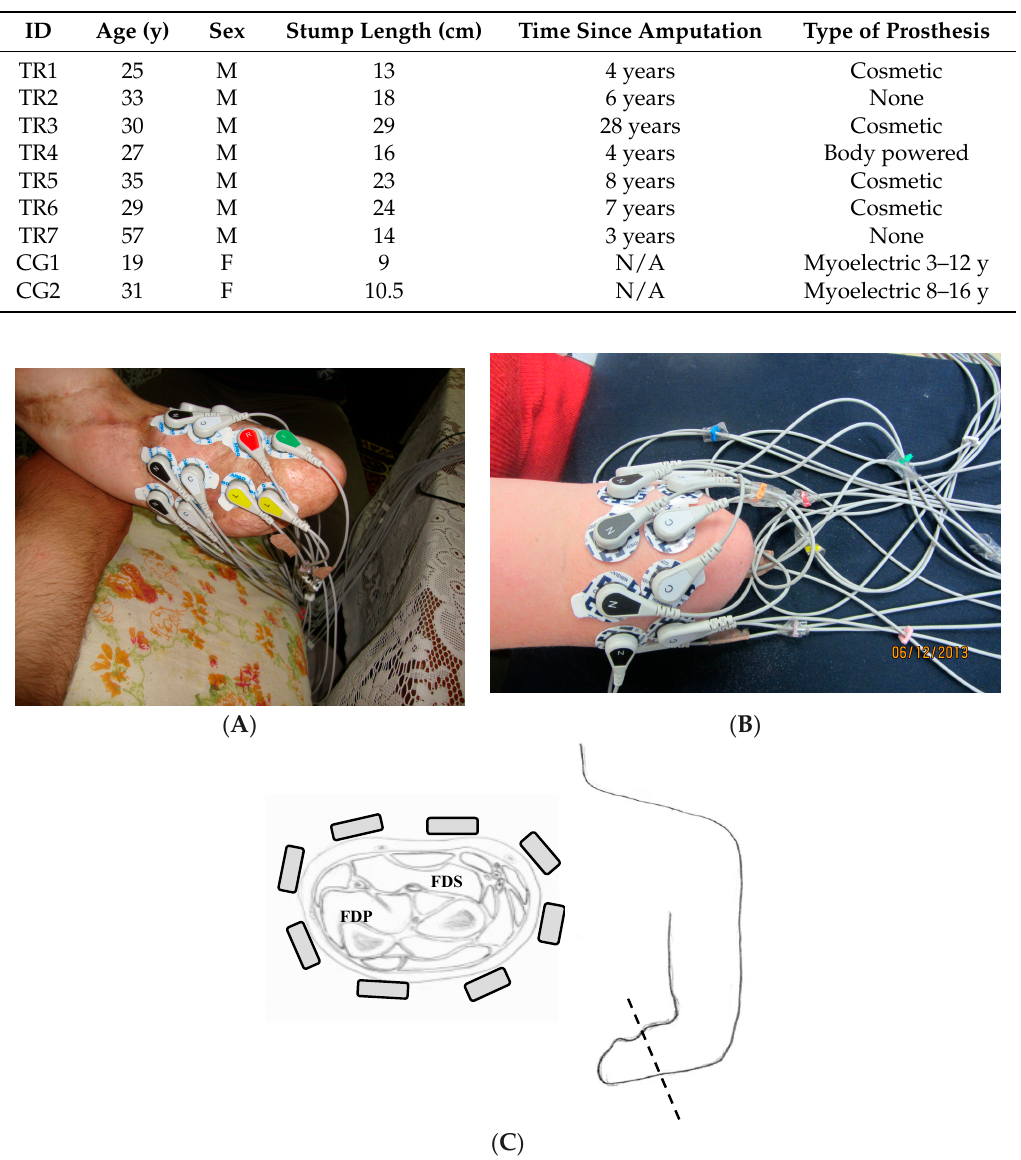
Table 1. The details of the demographic information of the transradial amputees recruited in this study.